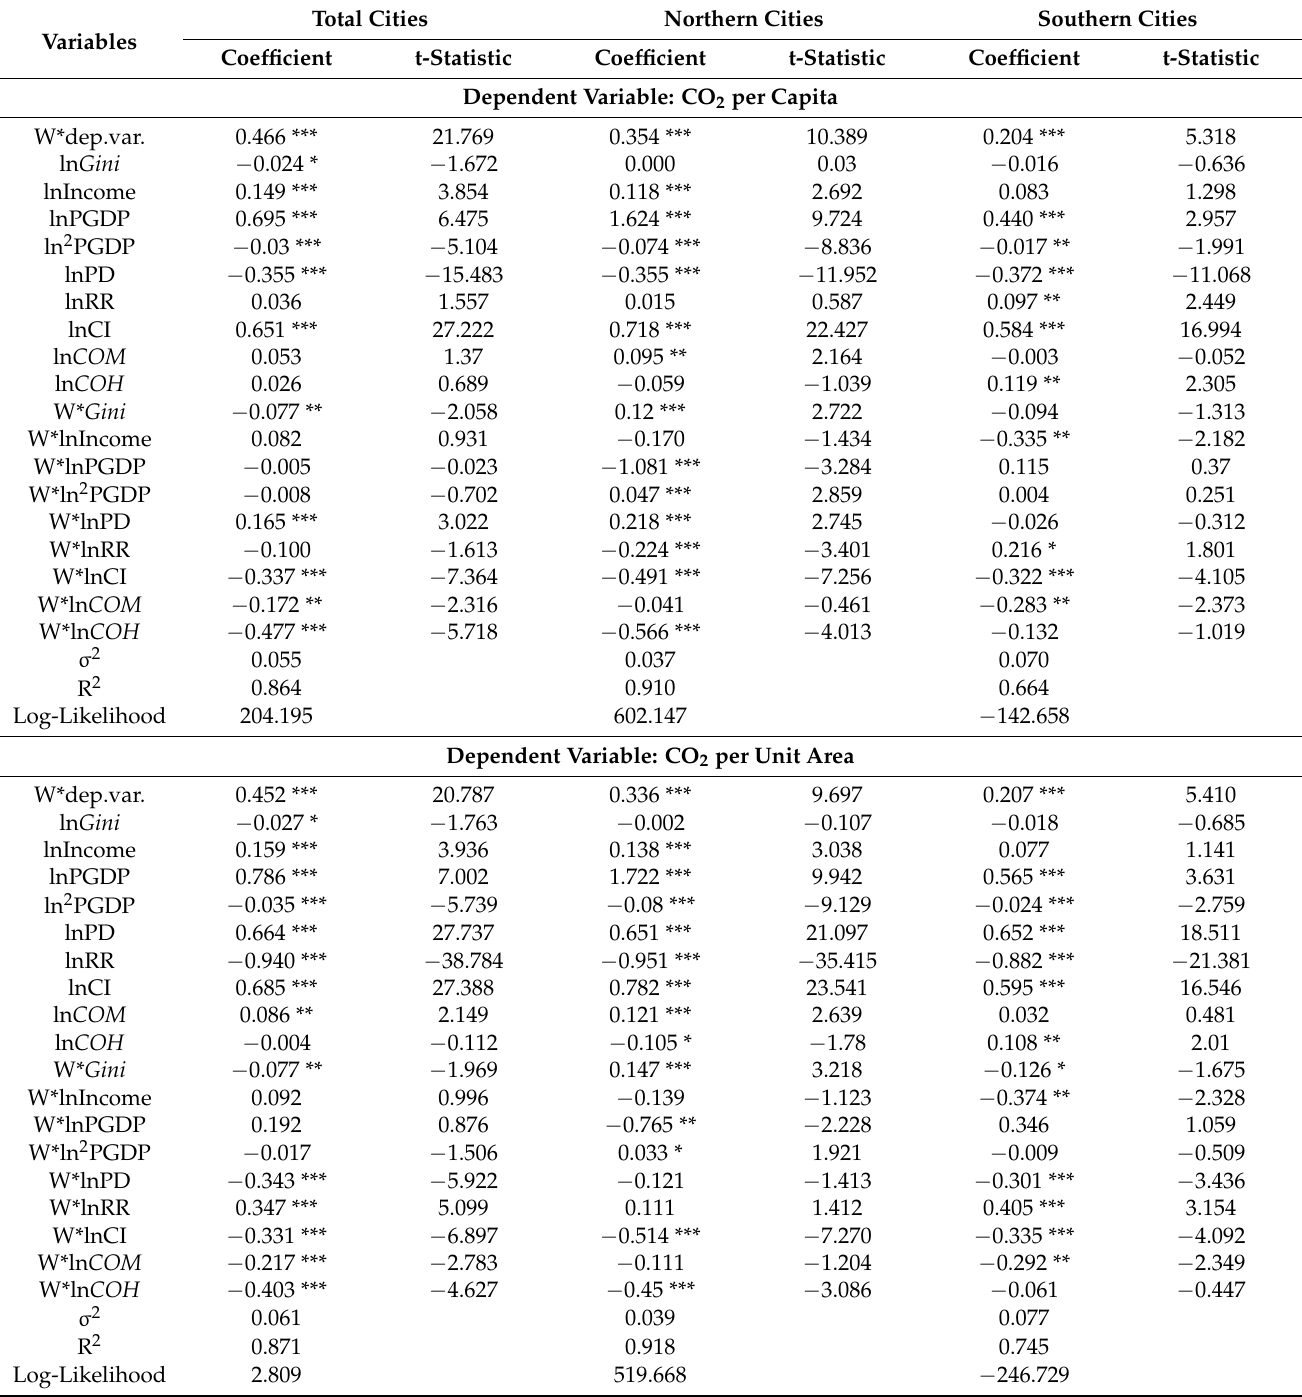
Table 2. Estimation results of SDM with spatial and time-period fixed